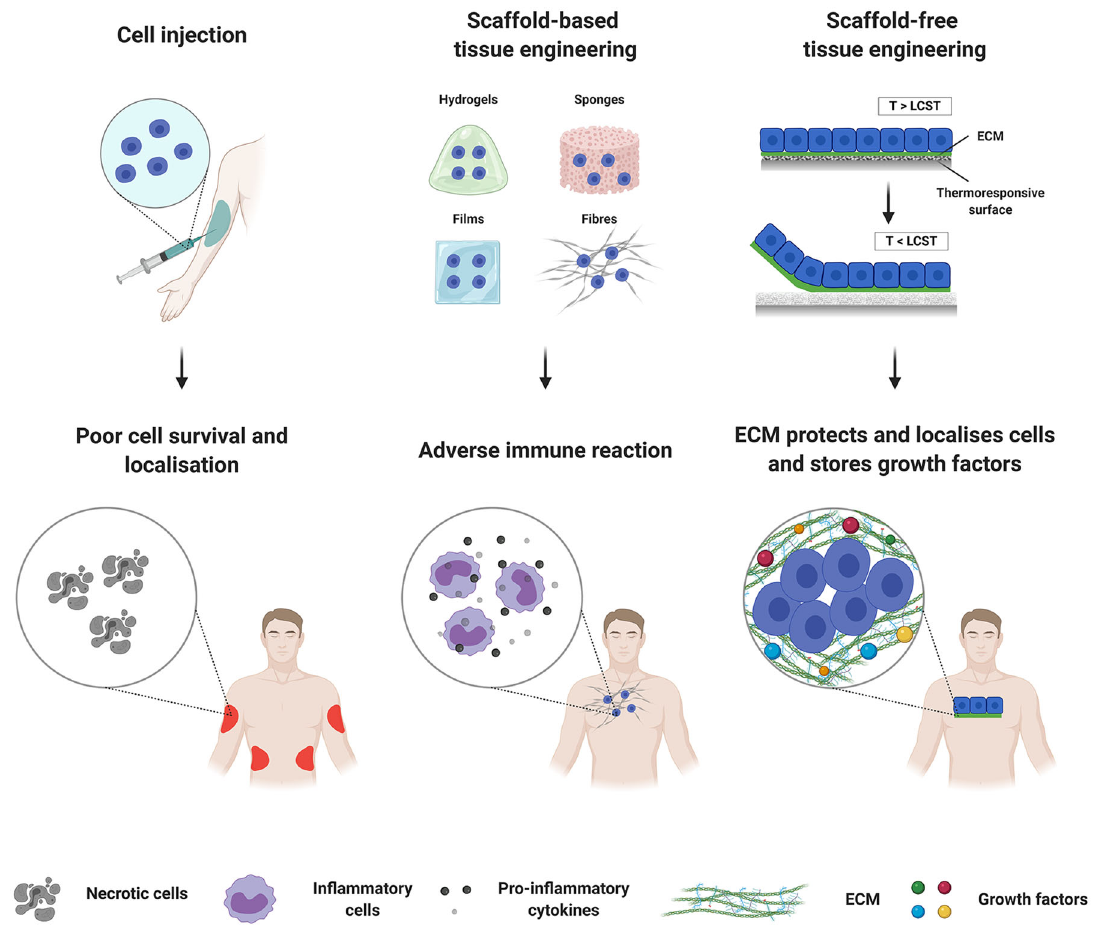
Fig. 1 Cell-based tissue engineering therapies. The fi gure was created with